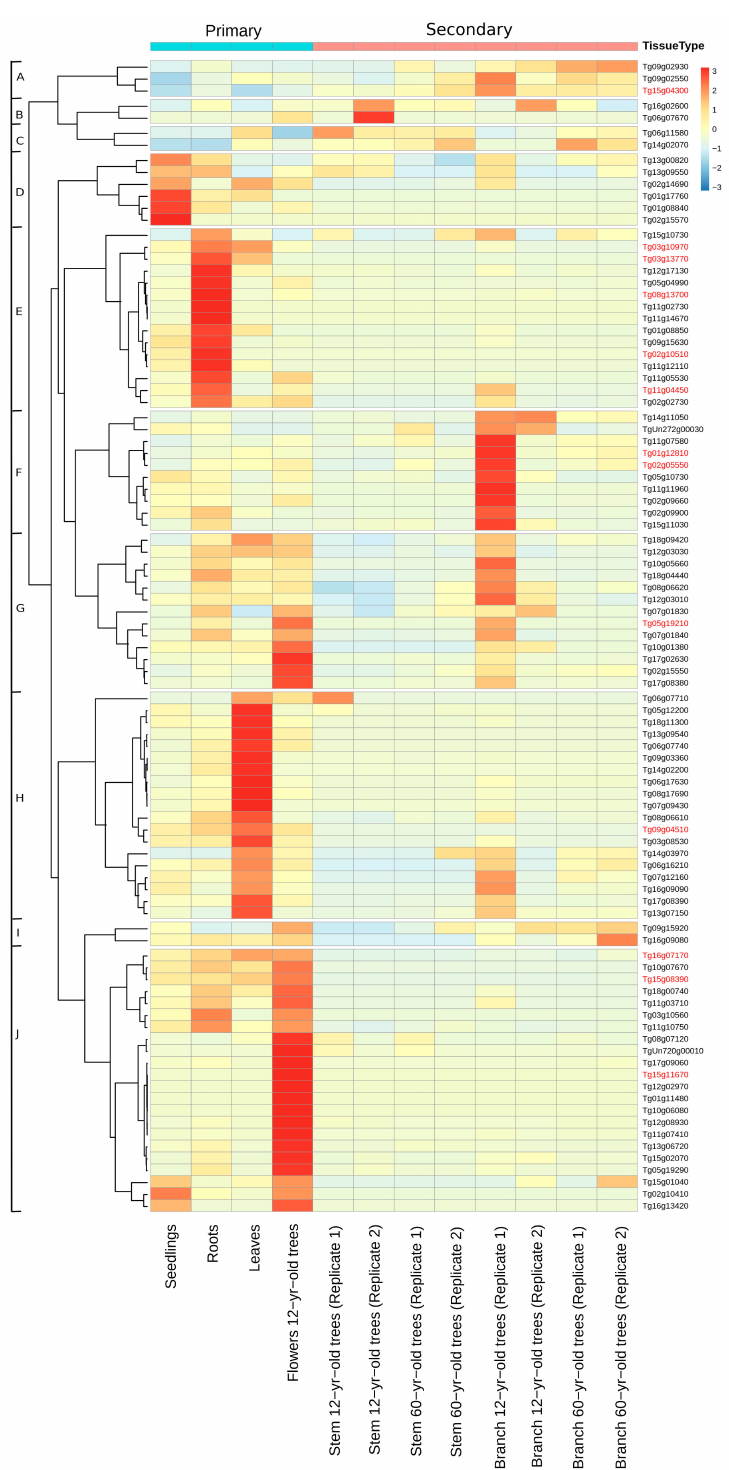
Figure 4. Hierarchical clustering of expression profiles of TgNAC genes in diverse T. grandis tissues. The 94 genes were clustered into 10 groups ( A – J ). Plant tissues (branch of 12- and 60-year-old trees; stem of 12- and 60-year-old trees, flowers, leaves, roots, and seedlings) were clustered according to the type tissue. The color scale on the left-hand side represents transcript per million (TPM). Gene expression values for each gene were transformed using Z -scores. Higher expression levels are represented in red, and lower expression levels are denoted in blue (Table S6). The TgNAC TF genes marked in red were selected for expression